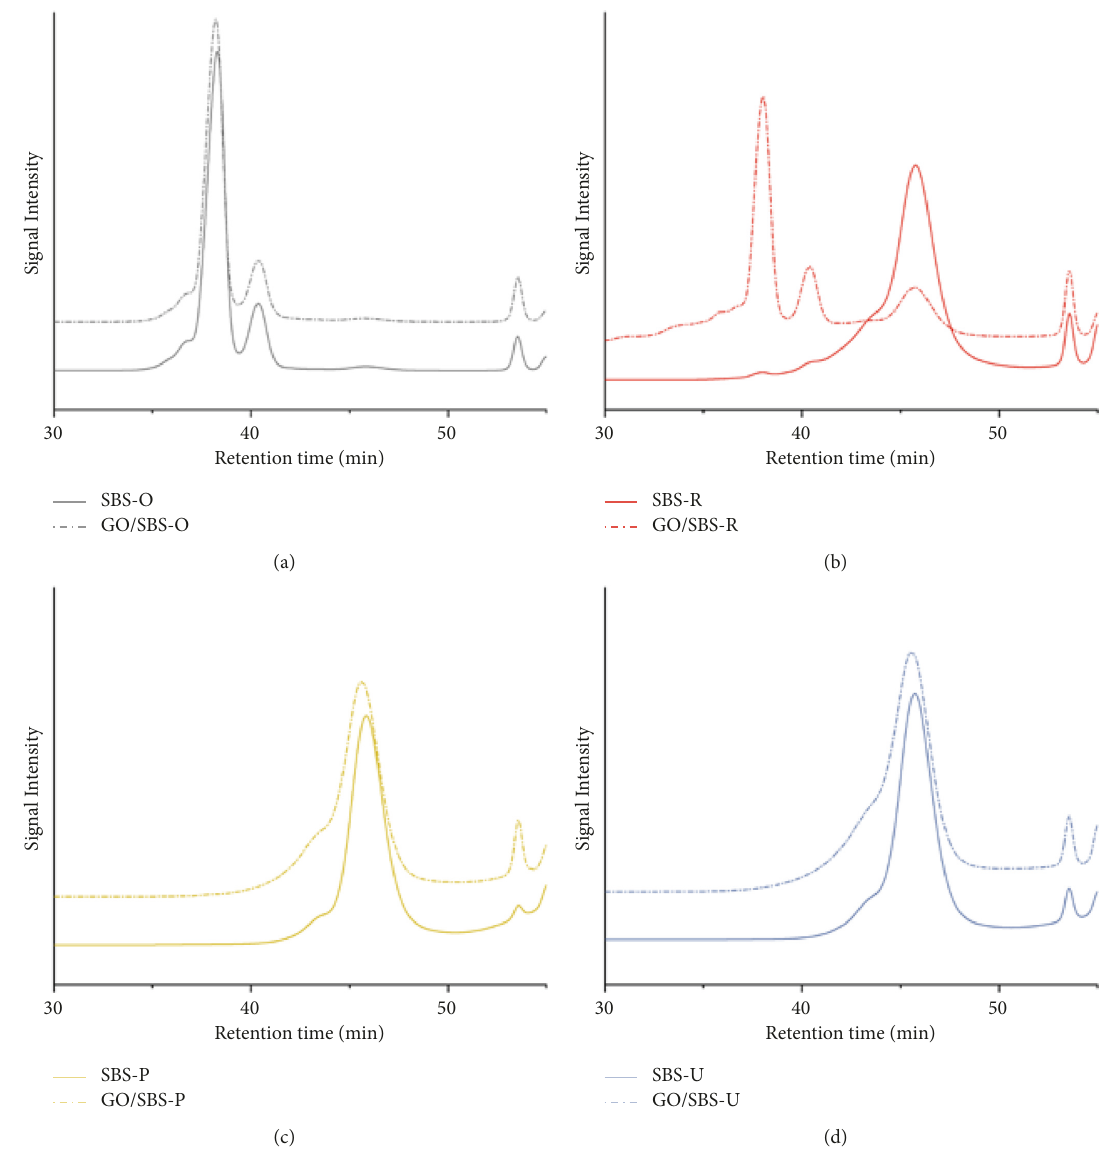
Figure 3: Curves of retention time versus signal intensity for SBS and GO/SBS at four aging states: (a) original, (b) RTFOT, (c) PAV, and (d)